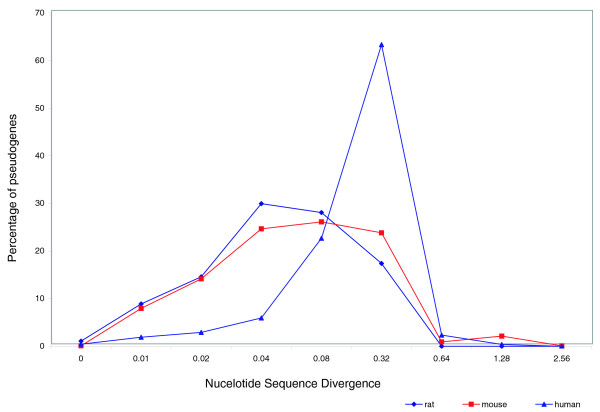
Processed pseudogenes grouped according to their nucleotide sequence divergence from the parent RP protein. The distances have been calculated using MEGA [28]. The distance is a measure of the number of nucleotide substitutions per site. For mouse and rat, the distances have been scaled by decreasing it by a factor of three based on the reported observation that a threefold-higher rate of base substitution in neutral DNA is found along the rodent lineage when compared with the human lineage [20].